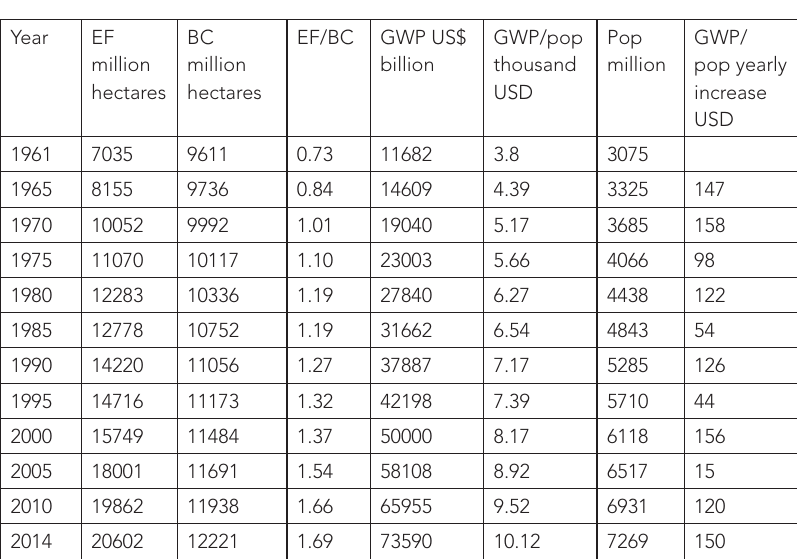
Table 1. Ecological footprint, biocapacity, gross world product